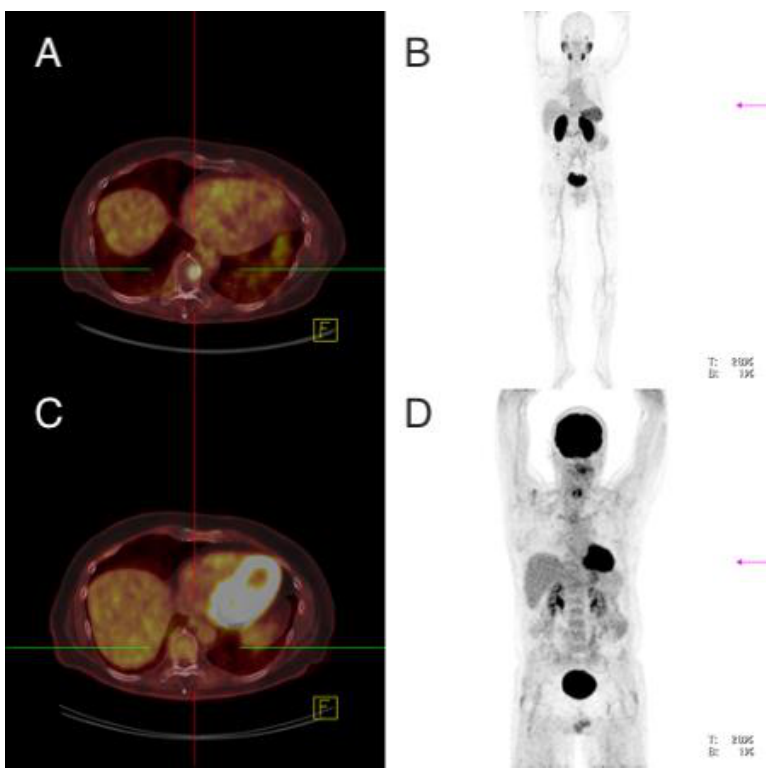
Figure 5. Patient 8. 68 Ga-PSMA-PET/CT ( A , B ), 18 FDG-PET/CT ( C , D ). Osseous metastasis thoracic vertebral body 9 with increased PSMA expression without increased glucose utilization.